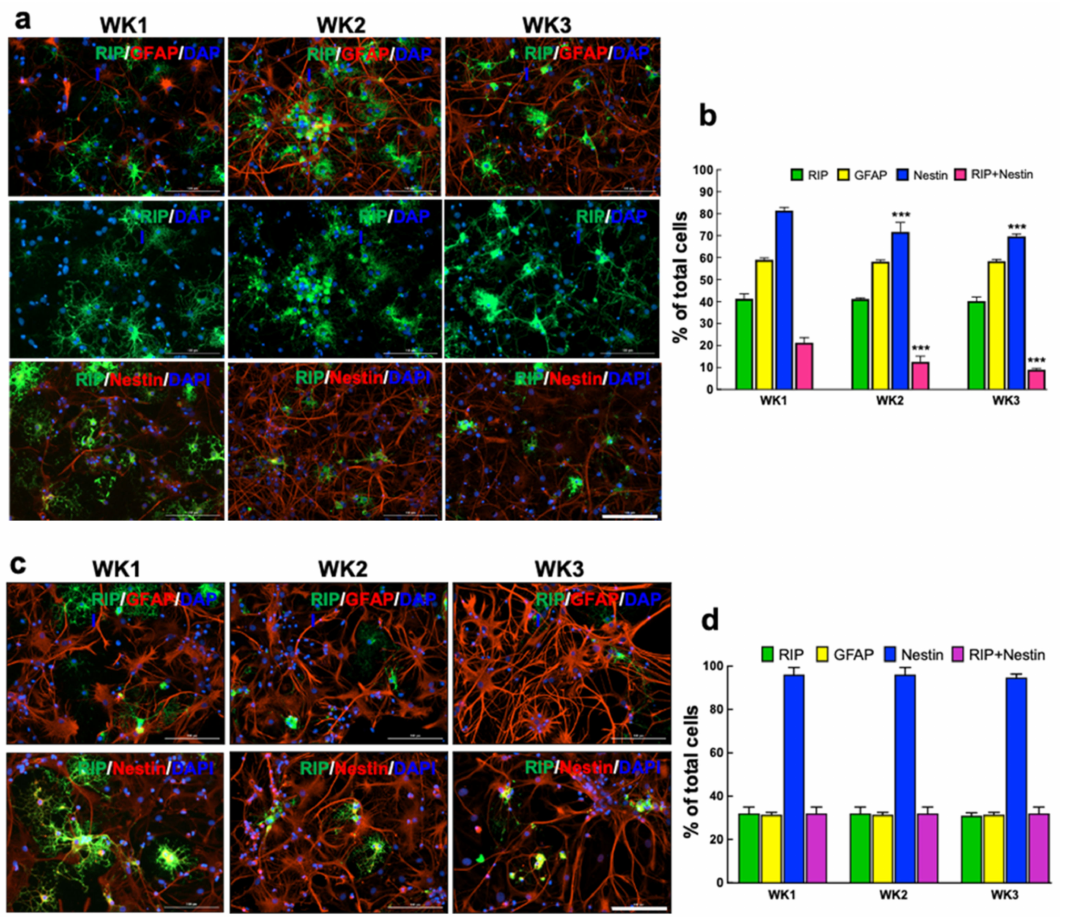
Figure 5. In vitro differentiation of NPCs into ODCs on AuNR substrates and PDL across three weeks. Immunostaining of NPCs differentiated on AuNR ( a ) and PDL ( c ) substrates at week 1, 2, and 3, using markers for oligodendrocyte (RIP, green), astrocyte (GFAP, red), intermediate filament protein (nestin, red), and nuclear stain (DAPI, blue). Scale bars: 100 µ m. Quantitative comparison of the percentage of cells expressing RIP, GFAP, and nestin at different time points on AuNR ( b ) and PDL ( d ) surfaces. Data show mean ± SD; comparison by two-way ANOVA with Dunnett analysis; *** p < 0.001 compared to the same cell type at week